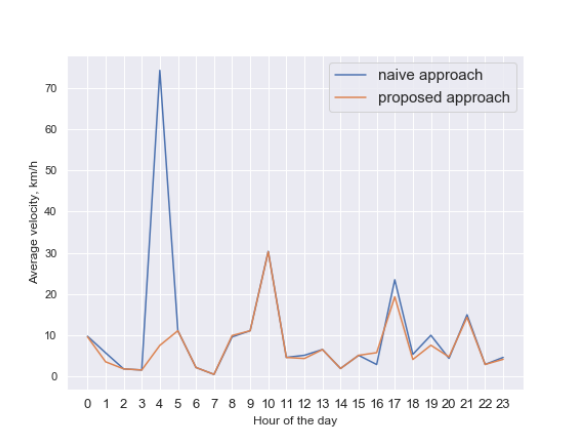
Figure 15. Trips distributions computed with naive and proposed approach—6 March 2017 and 1 March 2018, respectively. Travel distributions look similar.